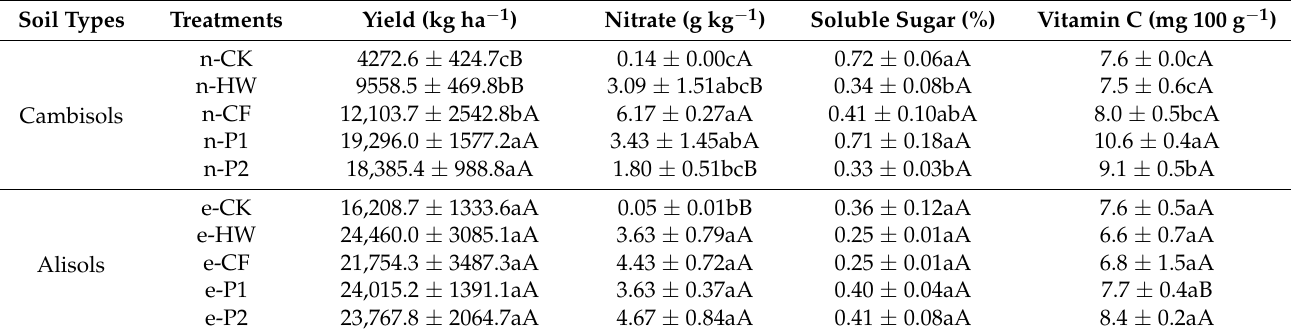
Table 4. Water spinach yield and